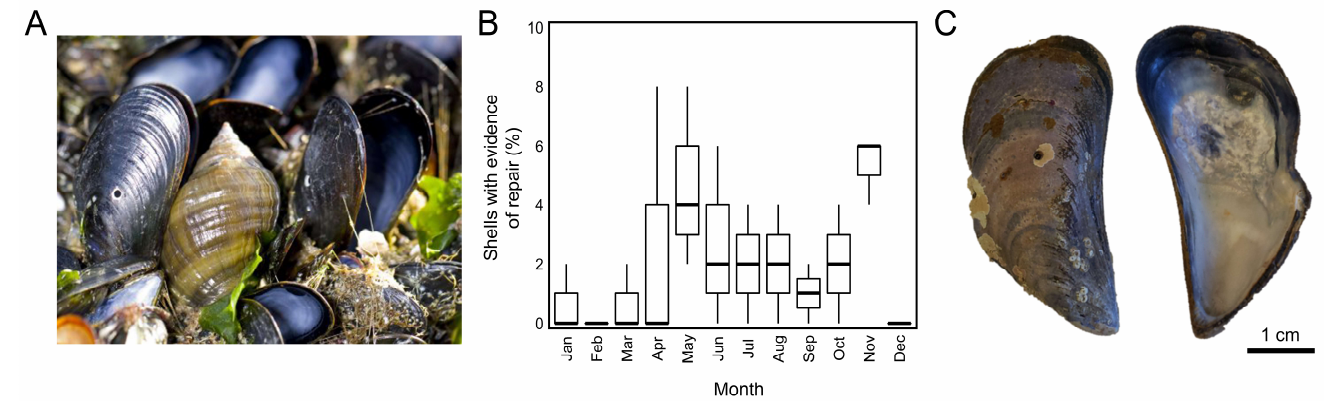
Figure 1. ( A ) Predation on mussels ( Mytilus edulis ) by predatory gastropods ( Nucella lapillus ; image credit: Luke Miller). ( B ) Mussels ( M. edulis, n = 50 per sample ) with evidence of repair of gastropod drill holes over 3 years of monthly field sampling in Rhode Island. ( C ) Exterior and interior view of a shell ( M. edulis ) with a repaired drill hole collected during field sampling within Rhode Island.